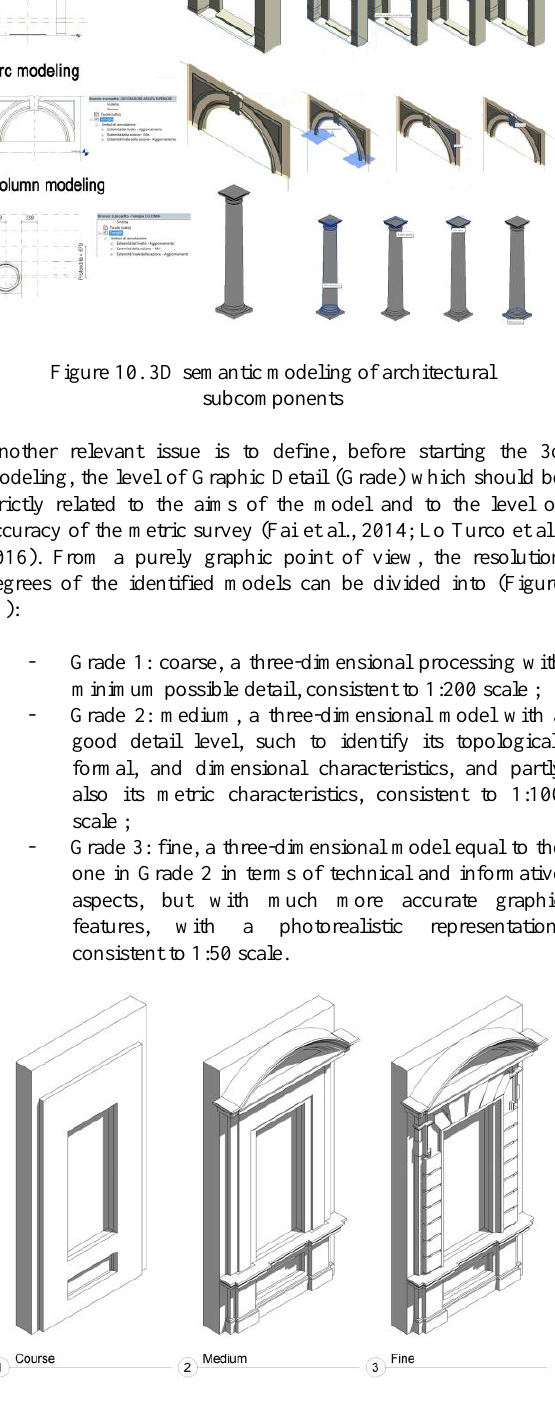
Figure 11. 3D modeling of the same building component according to several Graphic Details (GraDe).